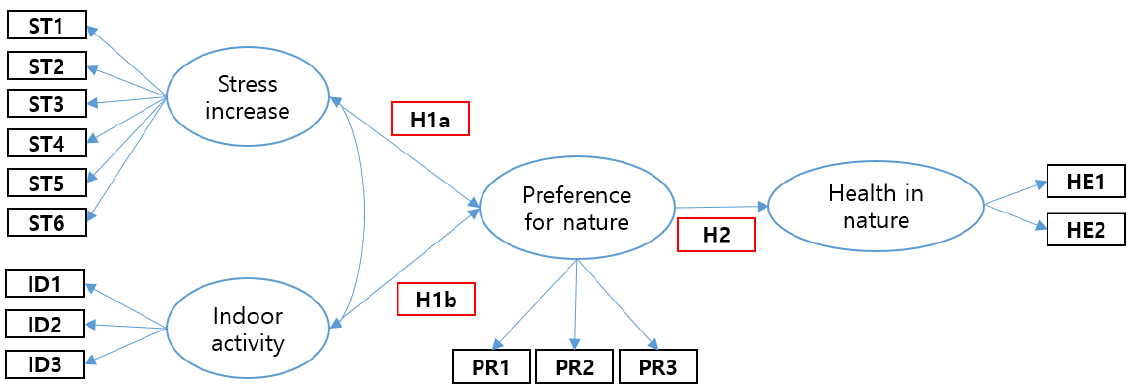
Figure 2. Revised Structural Equation Modeling Diagram.